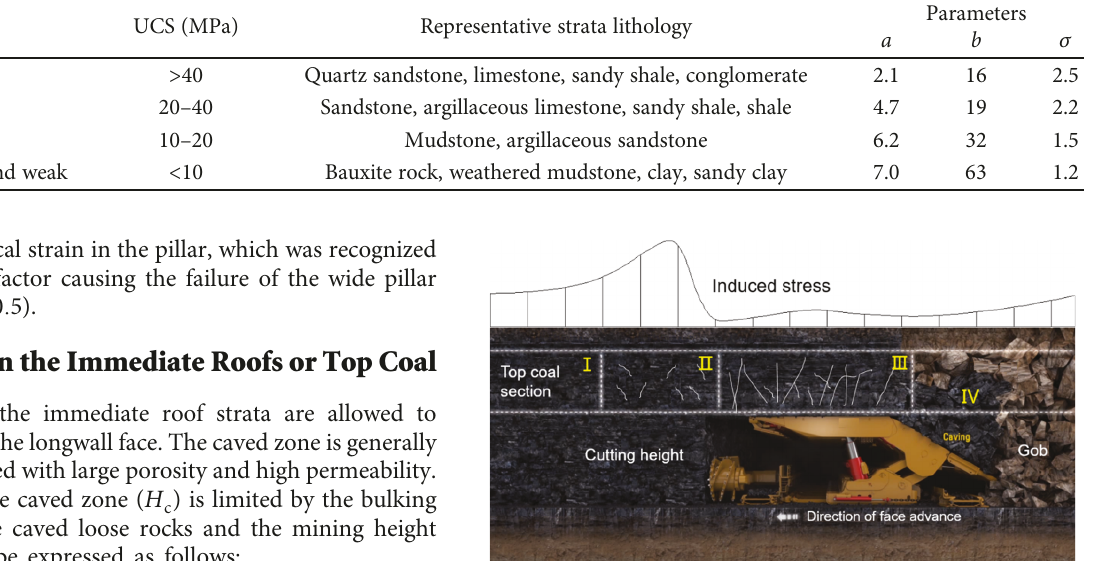
Table 1: Parameters for predicting the height of the caved zone H